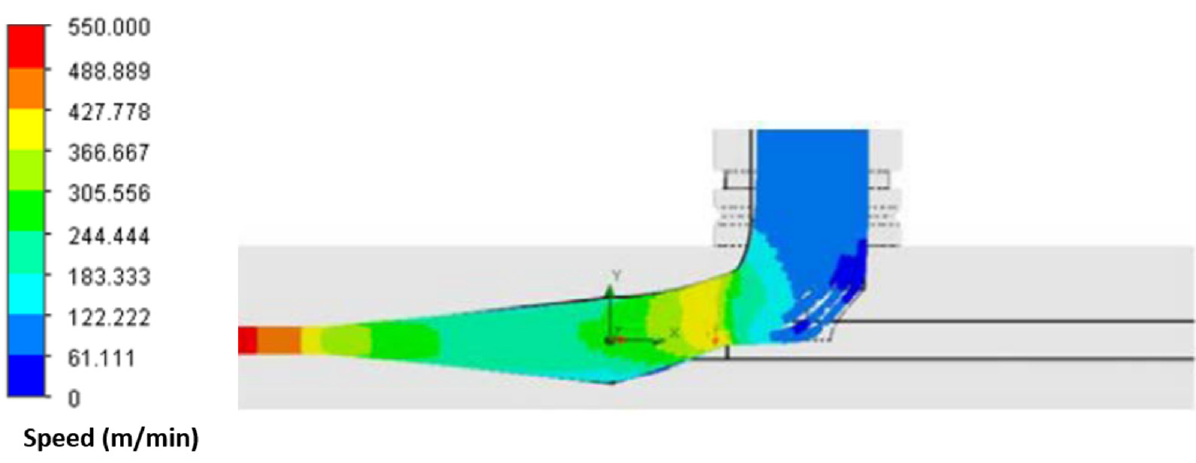
Figure 1. Optimized novel air-jet nozzle geometry with air flow profile.